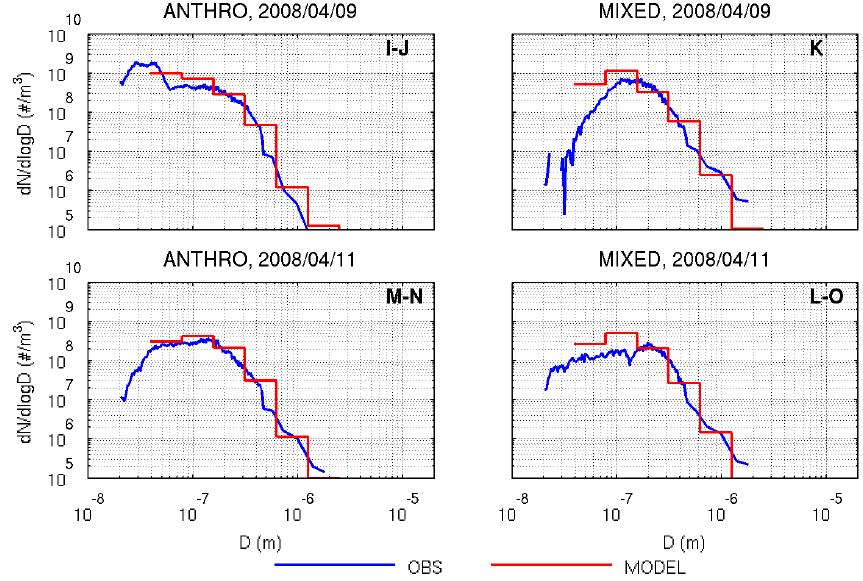
Figure 8. Modeled (red) and measured (blue) number size distributions of plumes labeled (I–O) in Fig. 7, influenced by (I, J, M, N) European anthropogenic and (K, L, O) mixed European anthropogenic and fire emissions. Modeled and observed size distributions corresponding to two consecutive samplings of the same plume during the same flight (I–J, M–N, L–O) were averaged